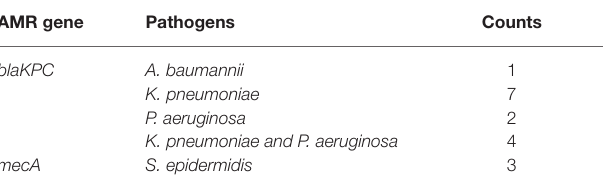
AMR genes, antimicrobial resistance genes.